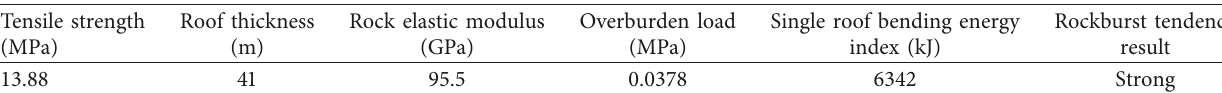
Table 1: Determination of rockburst